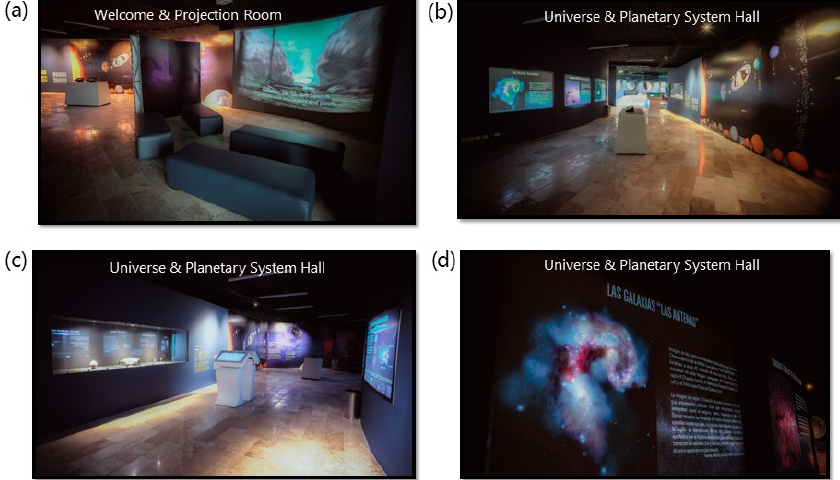
Figure 8. Chicxulub science museum and exhibits of the universe and solar